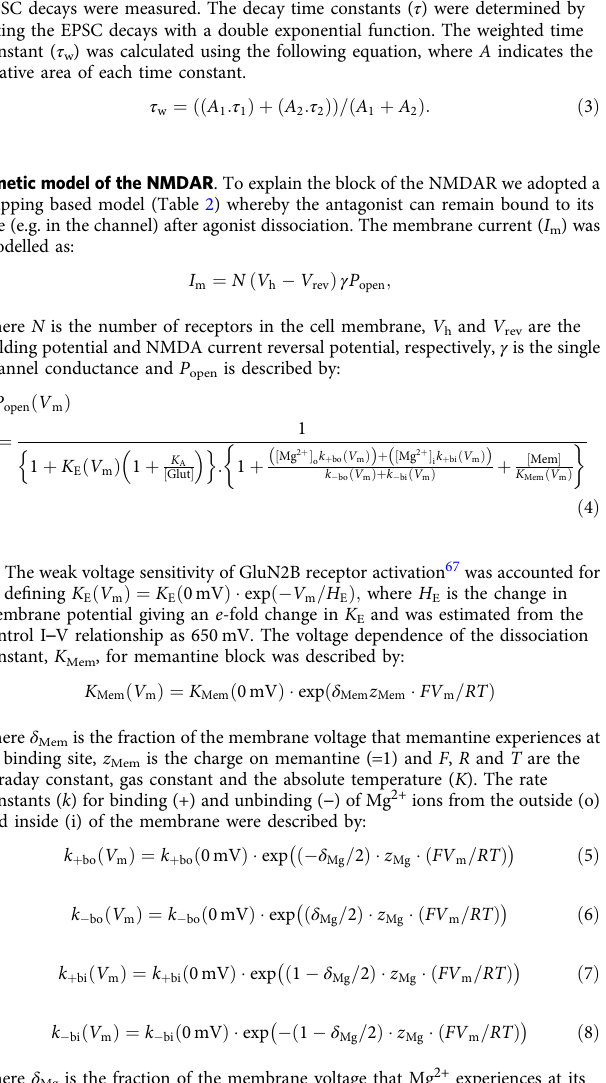
glutamine, 100 U/ml penicillin and 100 µ g/ml streptomycin, incubated at 37°C in 95% air and 5% CO 2 . Cells were plated on poly- L -lysine coated 22 mm coverslips